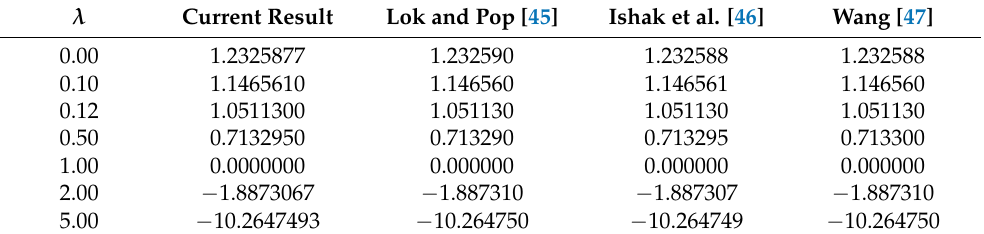
Table 3. Outcomes of f (cid:48)(cid:48) ( 0 ) with various λ when φ 1 = φ 2 = β = M = Ec = 0, α = 1.0, and Pr = 6.2.